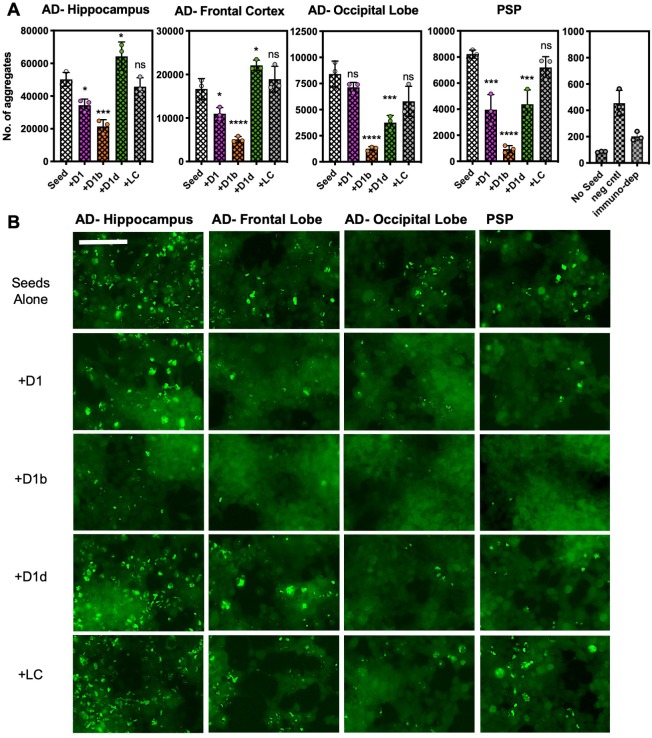
Peptide inhibitors reduce seeding by crude brain-extract from tauopathy donor tissue.Brain lysate was prepared in TBS buffer from three brain regions of one AD patient, and from a one sample of a PSP patient lacking Aβ plaques. Brain lysate from a non-disease patient (neg cntl) and a tau immunodepleted sample from PSP tissue are in right panel. Cells were seeded with a 1/400 dilution of brain tissue lysate; for samples with inhibitor, lysates were incubated with inhibitor overnight prior to addition to cells. A concentration of 10 µM peptide was used for all of the experiments shown. (A) The average number of aggregates seeded by lysate from each respective brain region, with or without addition of inhibitors. Bars represent mean with individual technical replicates (n = 3; ns = not significant; *, p<0.05; ***, p<0.0005; ****, p<0.0001 using an ordinary one-way ANOVA- Dunnett’s relative to leftmost column). (B) Representative images of seeded biosensor cells from A shown at 10X magnification, scale bar 100 μm. Extended ANOVA data included as a supplementary file.10.7554/eLife.46924.028Figure 7—source data 1.Tau biosensor seeding data points—brain lysate with and without inhibitor.